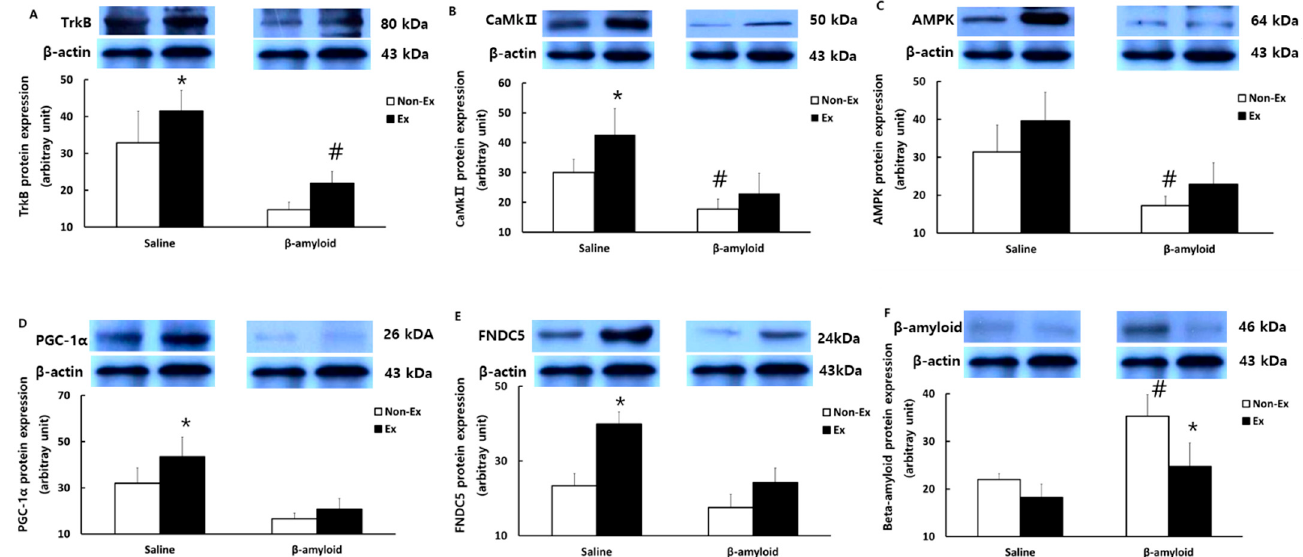
Figure 9. Comparisons of protein expressions of ( A ) TrkB, ( B ) CaMkII, ( C ) AMPK, ( D ) PGC-1 α , ( E ) FNDC5, and ( F ) β -amyloid in the cerebral cortex after the 12-week intervention. (* p < 0.05 Significant difference as compared to Non-Ex group; # p < 0.05 Significant difference as compared to Saline group).